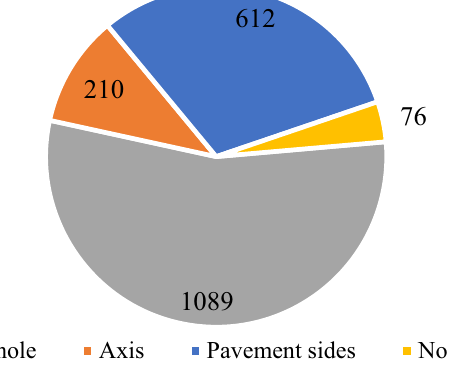
Fig. 3 Summation on the location of cracks at the paved cross